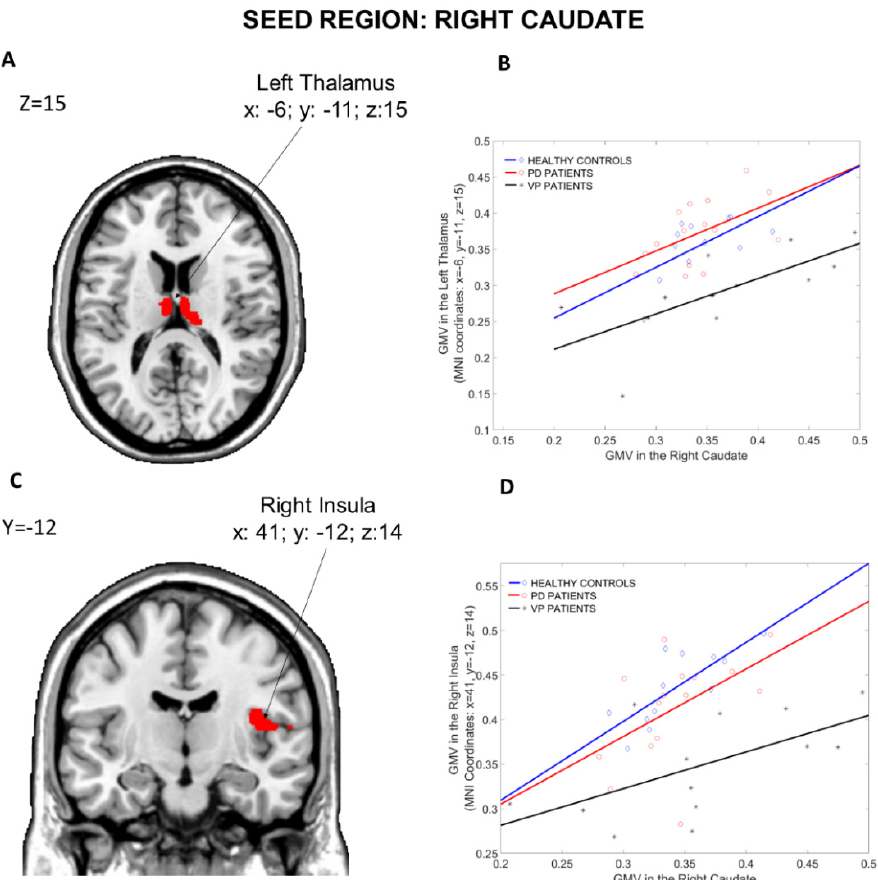
less than PD, VP more than HCs and VP more than PD).